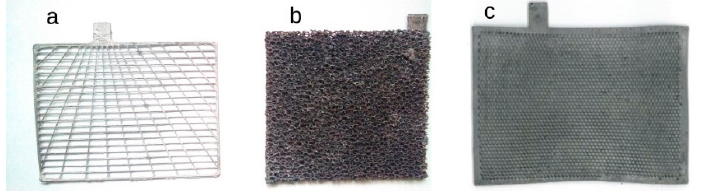
Figure 2. Typical ( a ), reticulated ( b ), and honeycomb (reprinted from [55] with permission from Elsevier) ( c ) current collectors for lead–acid batteries.